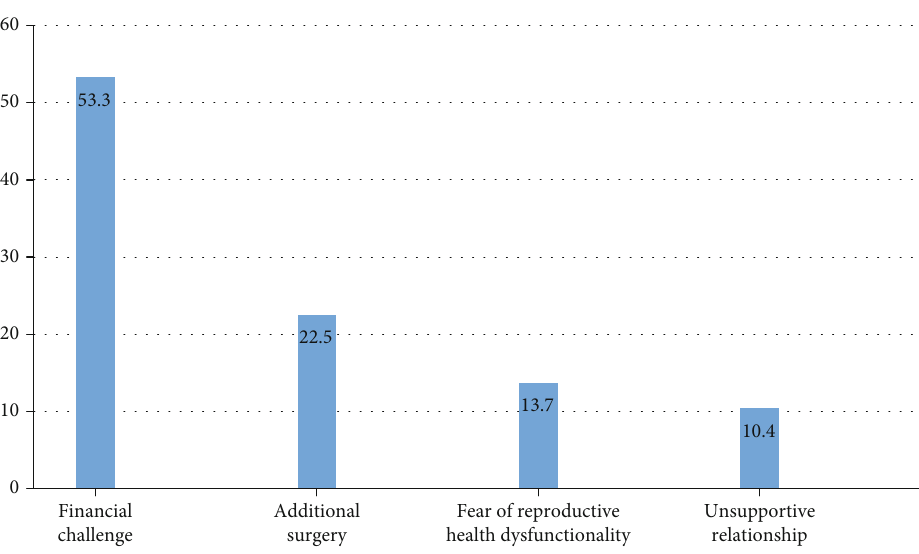
Figure 2: Percentage of fi stula survivors ’ ( n = 182 ) great burdens after the repair of their obstetric fi stula, central Gondar districts, Northwest Ethiopia,